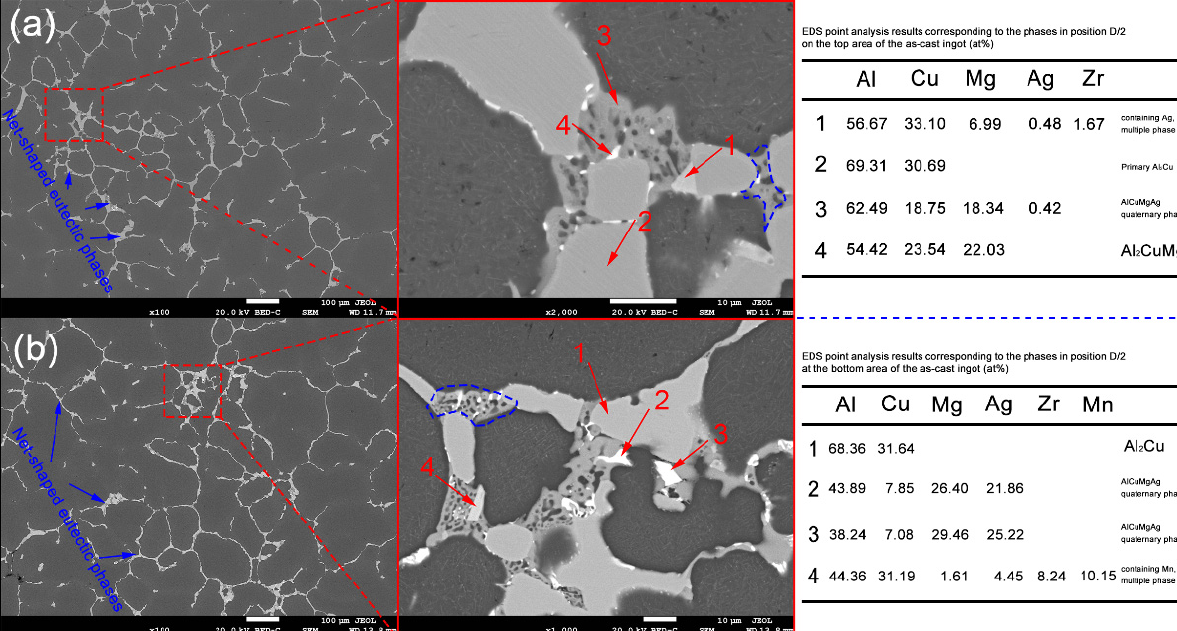
Figure 3. SEM ‐ BSE images and EDS point analysis results of the Al ‐ Cu ‐ Mg ‐ Ag alloy ( a ) D/2 position Figure 3. SEM-BSE images and EDS point analysis results of the Al-Cu-Mg-Ag alloy ( a ) D/2 position at the top of the ingot and ( b ) D/2 position at the bottom of the ingot. at the top of the ingot and ( b ) D/2 position at the bottom of the